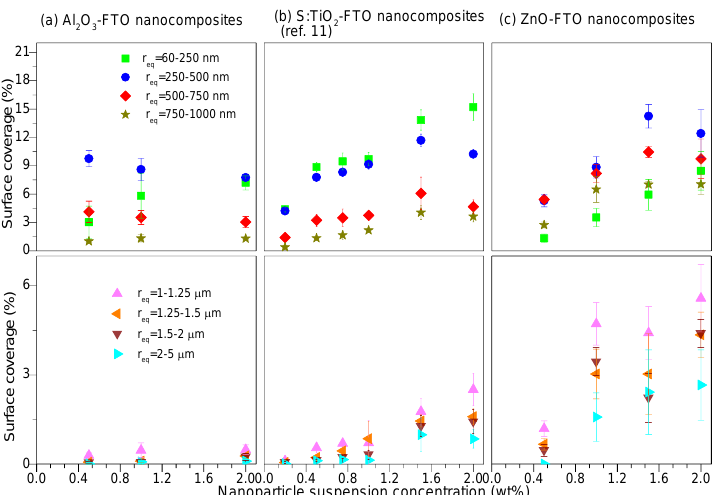
Figure 3. Surface coverages calculated for all eight groups (classified based on the equivalent radius r eq ) of nanoparticle agglomerates for ( a ) Al 2 O 3 -FTO nanocomposites; ( b ) S:TiO 2 -FTO nanocomposites (as reported in [11]); and ( c ) ZnO-FTO nanocomposites. For each series, the top and bottom panels show the surface coverage of groups with r eq inferior and superior to 1 µ m,